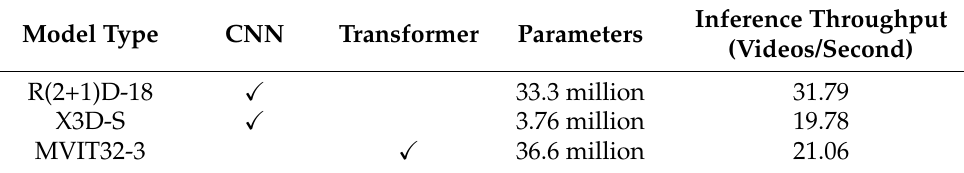
Table 1. Comparison of the deep learning